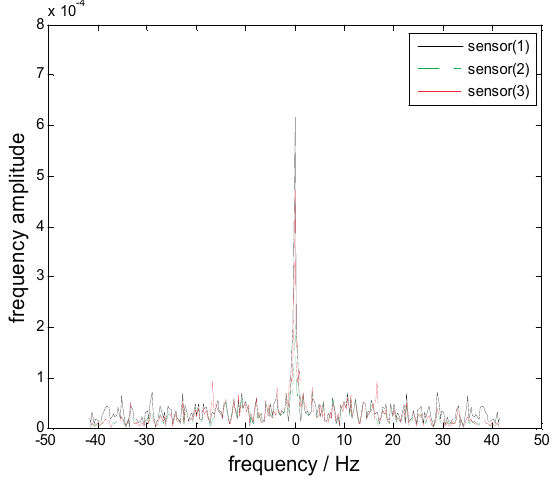
Figure 16. The frequency spectra of sample